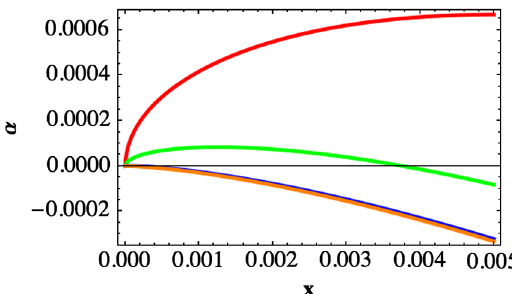
FIG. 8. Position of the negative spike in E 10 ; 20 ; 100 ; 1000 (red, green, blue, orange curves, respectively) from Eq. (22). It is worth noting that the accuracy of the position is O ð (cid:2) (cid:1) 3 Þ ; therefore the curves for (cid:2) ¼ 10 ; 20 are estimates of the peak position for the range shown.